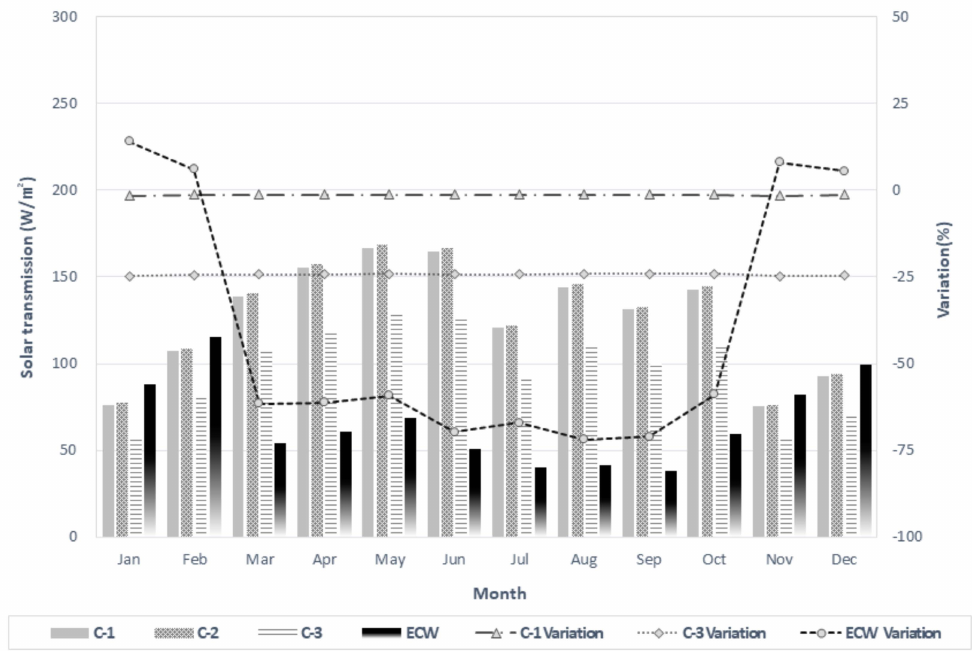
Figure 4. Solar transmission performance by direction (Monthly)—East.